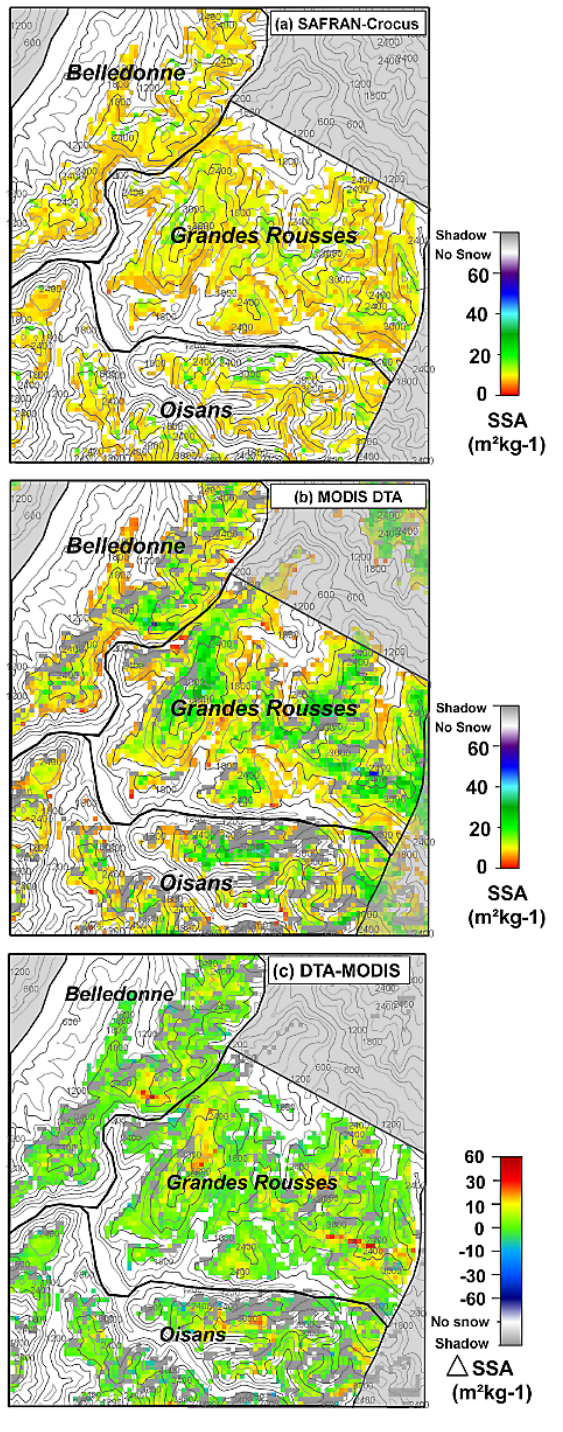
Fig. 6. SSA maps obtained from SAFRAN-Crocus (a) , DTA (b) , and difference DTA minus SAFRAN-Crocus (c) , for 2009-03-21. Elevation lines are 1000m spaced. Grey pixels are shaded areas. Pixels not detected as snow are indicated in white. Delimitation of the SAFRAN massifs Belledonne, Grandes-Rousses and Oisans are also